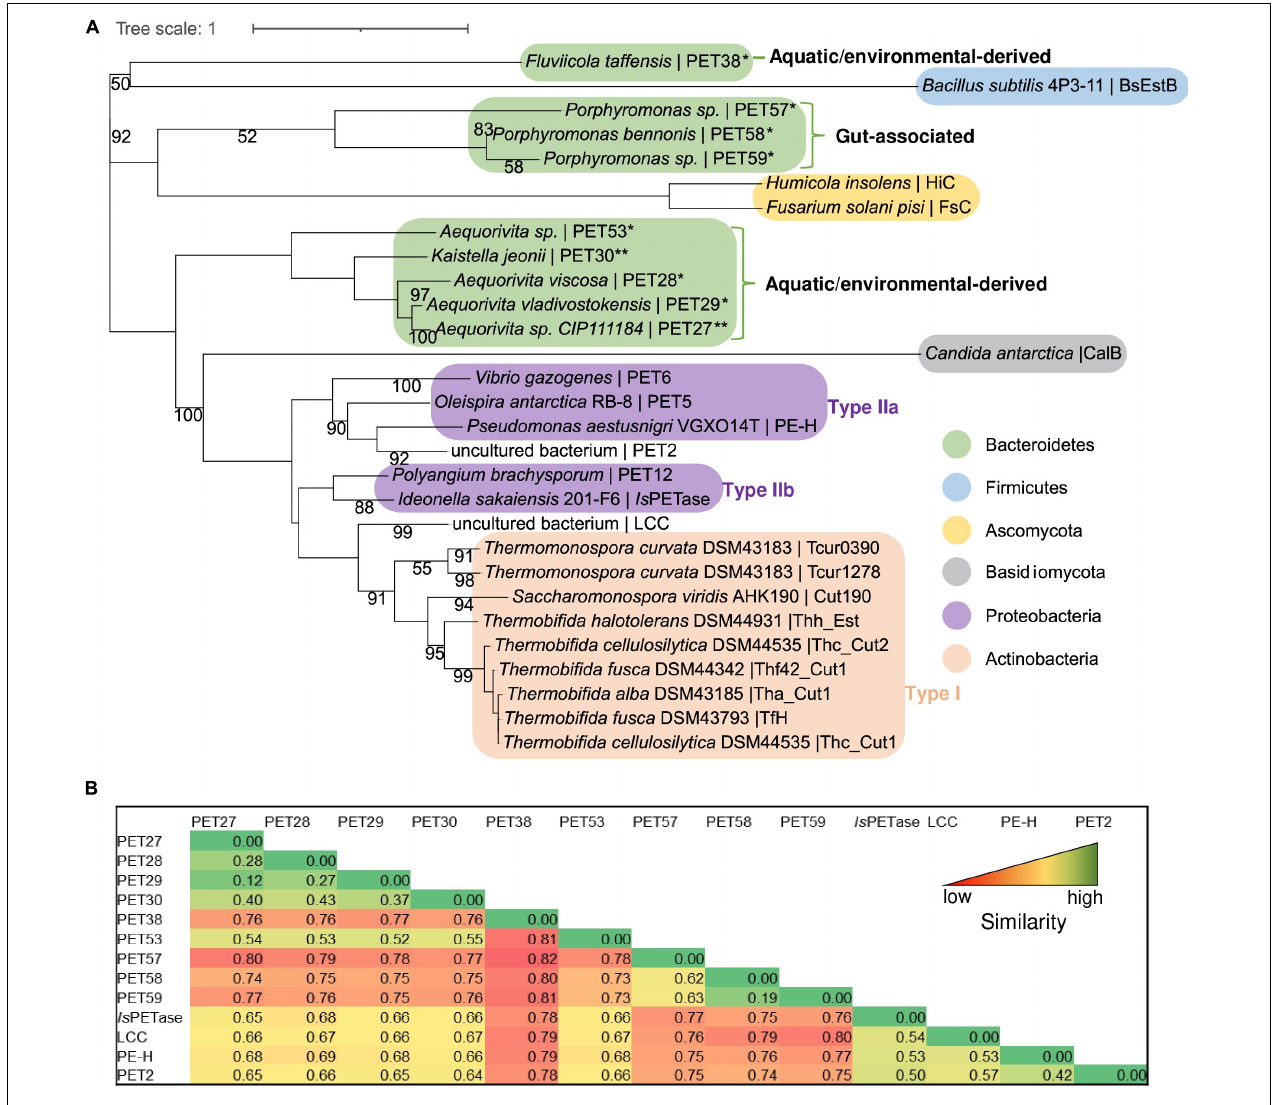
FIGURE 5 | Phylogenetic tree and pairwise comparison of known PETases and bacteroidetal PET-hydrolyzing enzymes. (A) The tree was constructed using the RAxML-NG autoMRE algorithm (Kozlov et al., 2019) with the treesapp create command implemented in TreeSAPP (Morgan-Lang et al., 2020) with maximum bootstraps set at 1,000. GenBank entries of the putative and verified PET-active enzymes affiliated with the Bacteroidetes phylum are listed in Table 1 ; the entries of all other PETases included in the tree are indicated in Supplementary Table 3 . The term “uncultured bacterium” refers to a not further specified microorganism derived from a metagenome or a mixed microbial consortium. (B) Heatmap representation of pairwise similarities between all enzymes affiliated with the Bacteroidetes phylum in comparison with four known PETases ( Is PETase, LCC, PE-H, and PET2). The pairwise comparison was performed in MEGAX with the p -distance model. High values indicating low similarity are colored in red, low values indicating high similarity are colored in